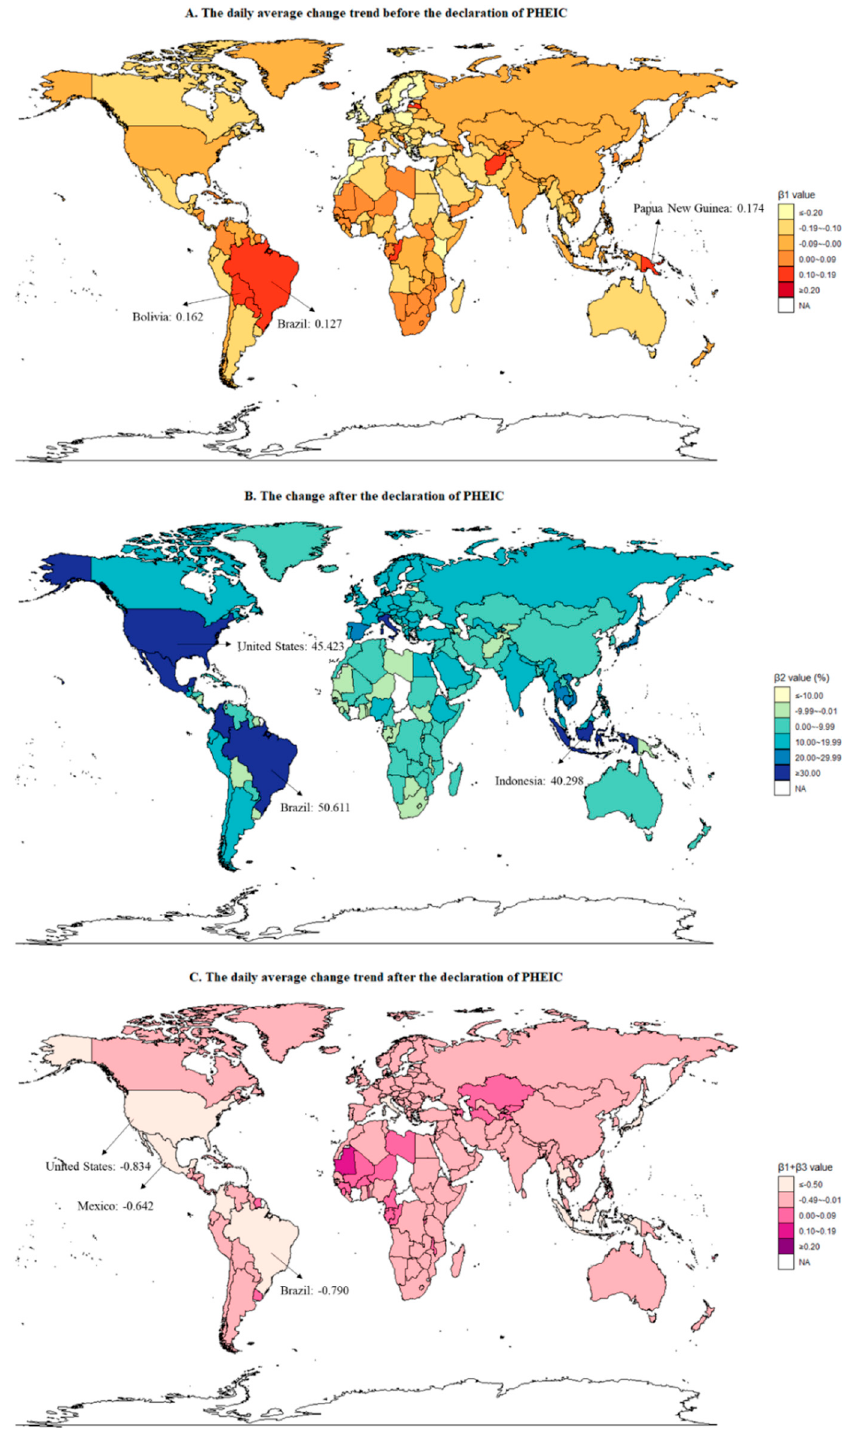
Figure 2. The trend and change in online search activity before and after public health emergency of international concern: ( A ) the daily average change trend of online search activity before the declaration of PHEIC; ( B ) the change of online search activity after the declaration of PHEIC; ( C ) the daily average change trend of online search activity after the declaration of